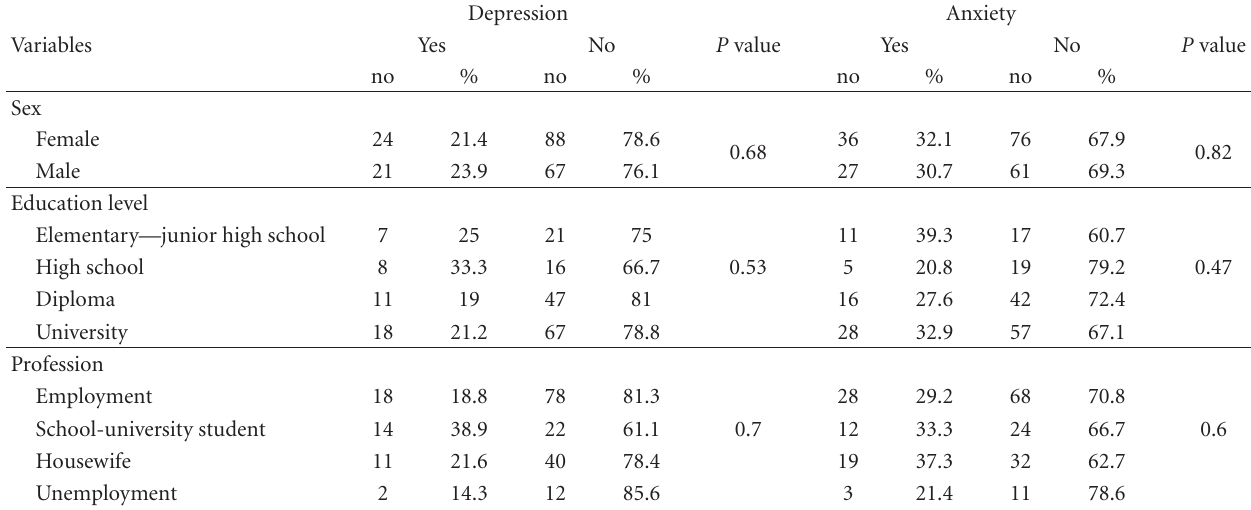
Table 1: Demographic variables based on anxiety and depression in psoriatic